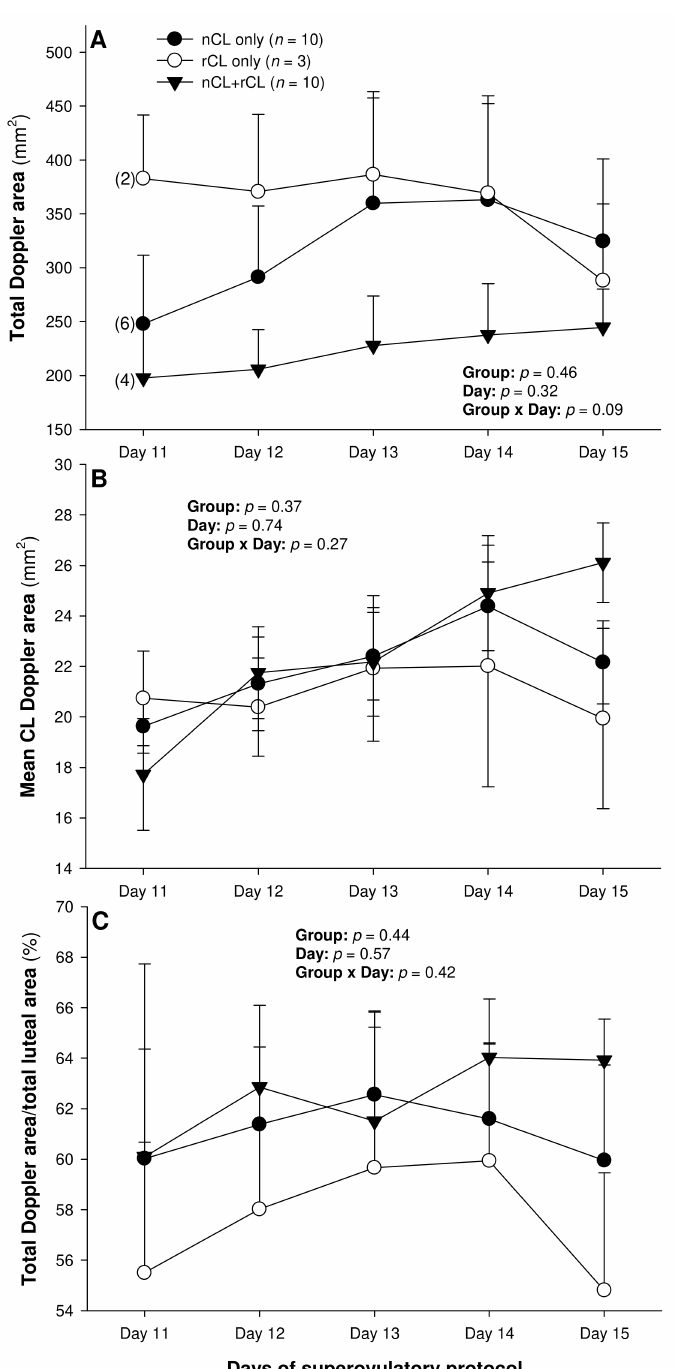
Figure 6. Total ( A ) and mean luteal Doppler area ( B ), as well as luteal vascularization percentage (total Doppler are/total luteal area × 100%) ( C ), from Day 11 (1 or 2 days after ovulation or beginning of luteogenesis) to Day 15 (day of embryo recovery) of the superovulatory protocol in Santa In ê s ewes that had normal CL (nCL) only, regressing CL (rCL) only, or both nCL and rCL following the superovulatory pFSH treatment. Numbers in parentheses (panel A ) denote the numbers of ewes in which CL were detectable ultrasonographically on Day